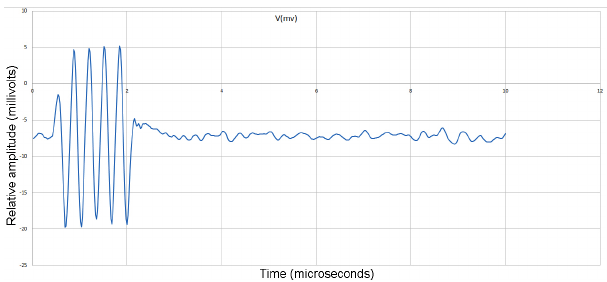
Figure 12. The graph shows the relative amplitude (millivolts) as a function of time (microseconds) as viewed on an oscilloscope with input from a laser interferometer (Polytec Model OFV505) for the out-of-plane displacement of a cylinder surface. The acoustic source is a spray-on bismuth titanate transducer with a 100V excitation signal on the opposite end of the cylinder. The cylinder is a metal alloy (Invar 42) with dimensions 1.27cm in diameter and 2.54cm in length. The estimated signal-to-noise ratio is